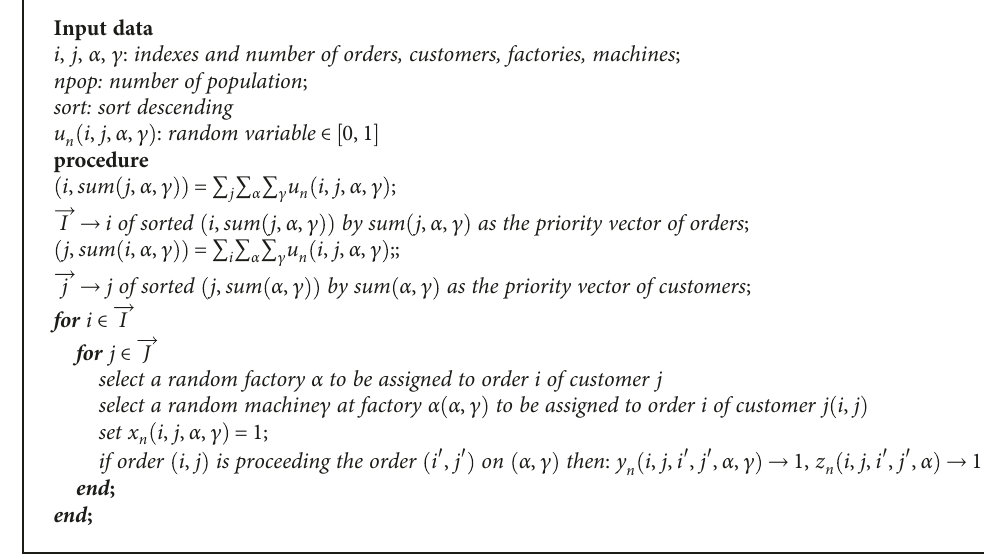
Figure 4: An example